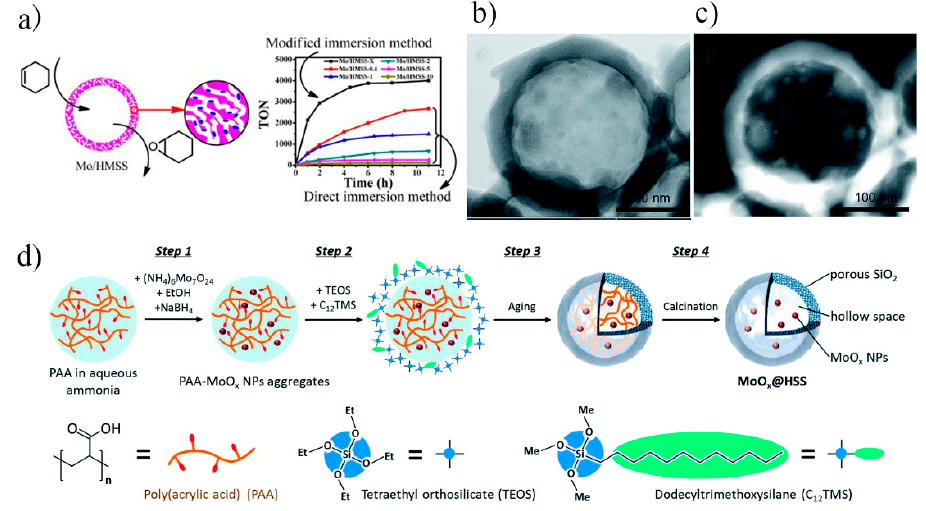
Figure 4. ( a ) Epoxidation process (left) and turnover number (TON) (right). Reproduced with permission from reference [86]. Elsevier (2017). ( b ) Scanning transmission electron microscope (STEM) image of MoO x @HSS-2; ( c ) high-angle annular dark-field imaging STEM (HAADF-STEM) image of MoO x @HSS-2; ( d ) Schematic illustration of the preparation process of MoO x @HSS. Reproduced with permission from reference [87]. Royal Society of Chemistry (2017).